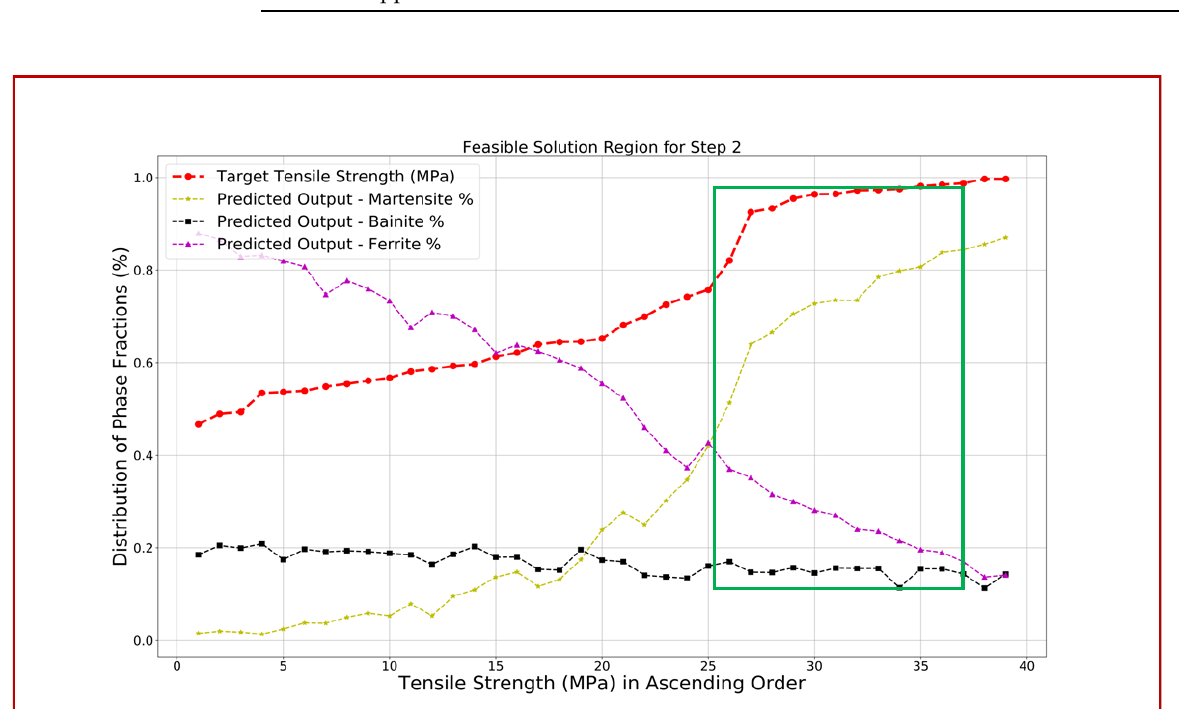
Figure 9. Feasible Region for Microstructure Parameters.